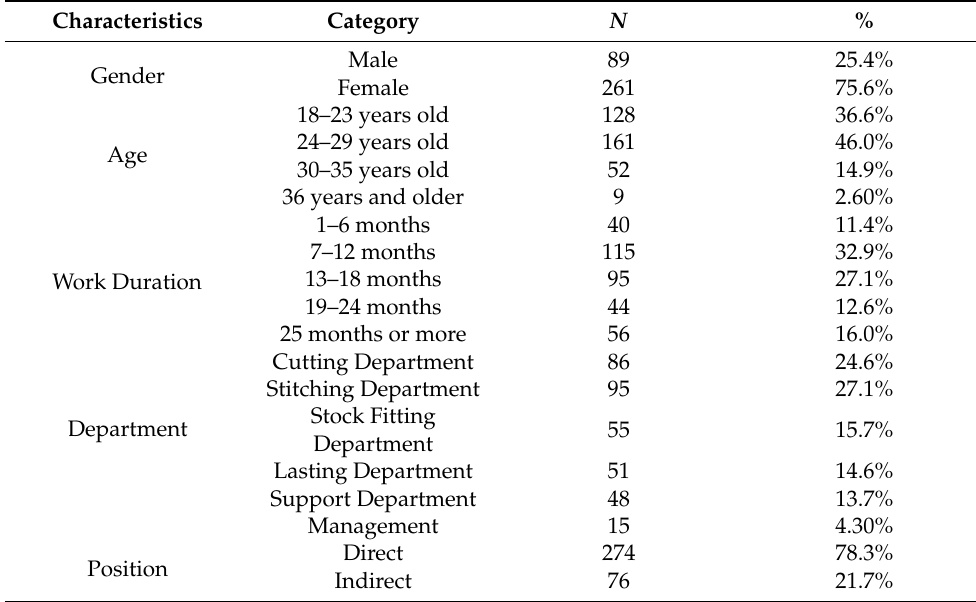
Table 2. Descriptive statistics of